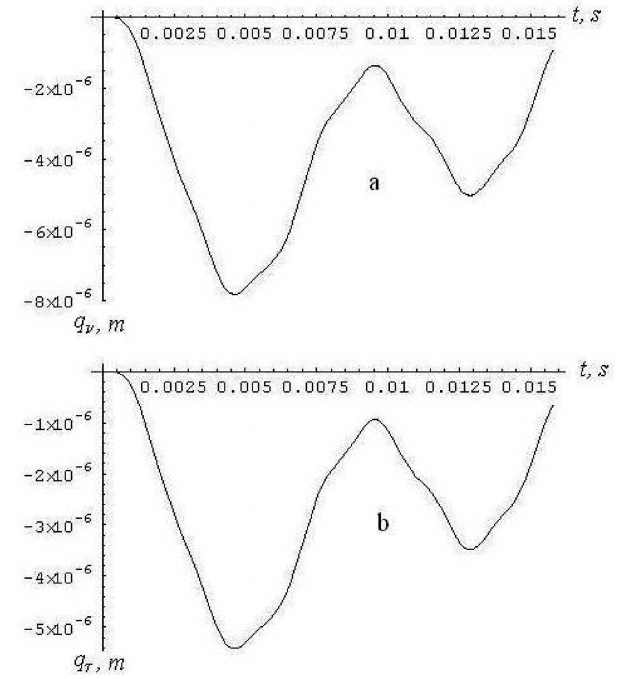
Fig. 7. Normal (a) and tangential (b) components of the displacement of the free ends of the stabilizer side rods (with angle of rod inclination α = 17 ◦ and separation angle β = 35 ◦ ) . vibration. The decrement of dissipation measures the speed of damping of vibration. A parameter which varies inversely to the decrement is the number of circles required to decrease the amplitude e ≈ 2.7 times. Taking into account the fi rst and second maxima (Fig. 7), in the computer simulation results, δ = 0.24–0.29. This number